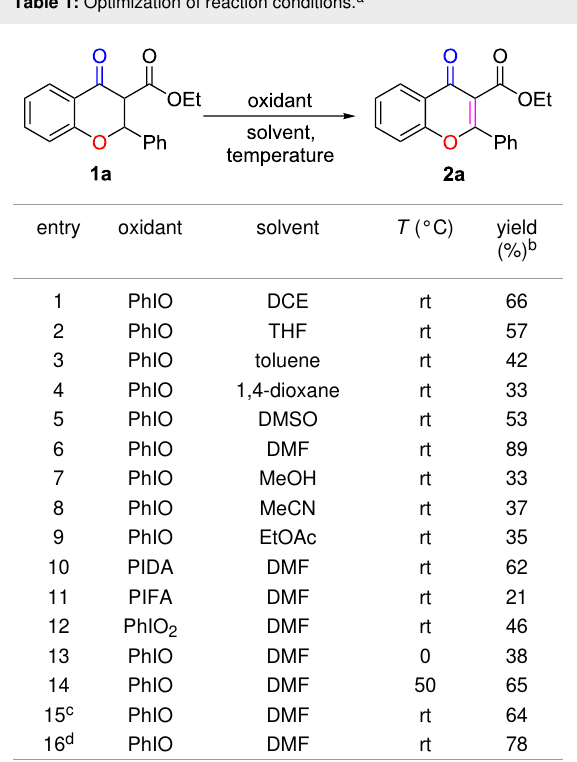
Table 1: Optimization of reaction conditions.